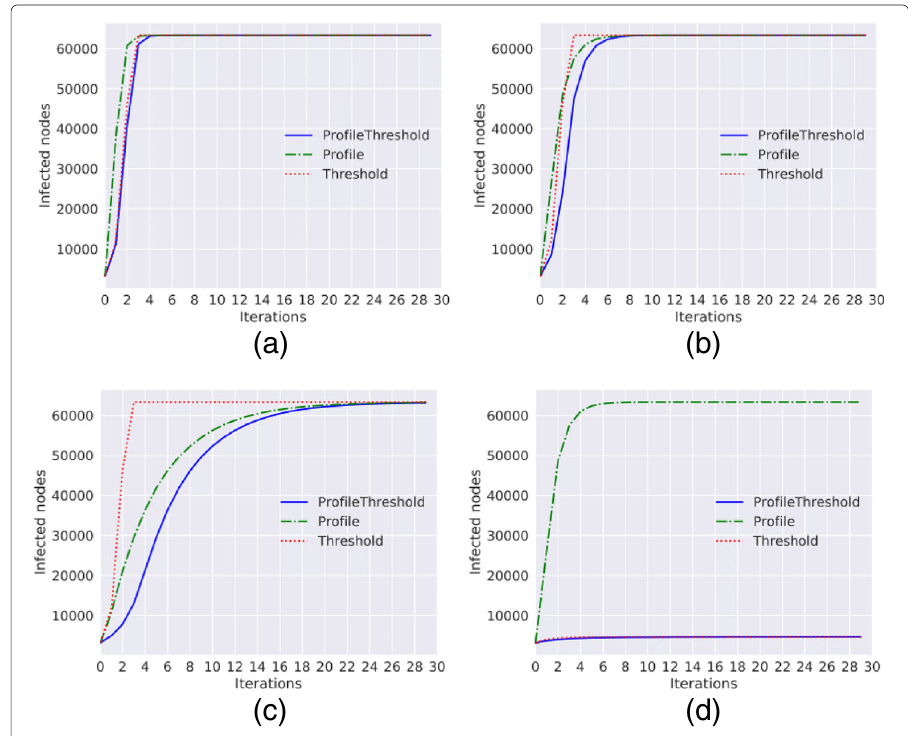
Fig. 1 Diffusiontrendsfor the Barabasi Alberth graph. Diffusion trends for Threshold , ProfileThreshold and Profile model with a = 0 and p = 0 and with different values of γ and τ . a γ = 0.1, τ = 0.1 b γ = 0.4, τ = 0.1 c γ = 0.8, τ = 0.1 d γ = 0.4, τ =